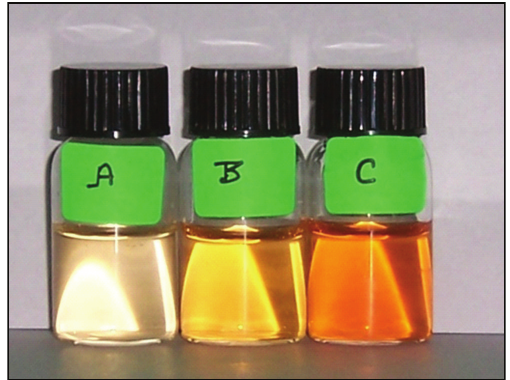
Figure 1: Aqueous selenium nanoparticle sols obtained by the reaction of (A) 2 . 0 × 10 − 4 (B) 5 . 0 × 10 − 4 (C) 1 . 0 × 10 − 3 moldm − 3 sodium selenosulphate with 2 . 0 × 10 − 2 moldm − 3 acetic acid, in the presence of 0.05%